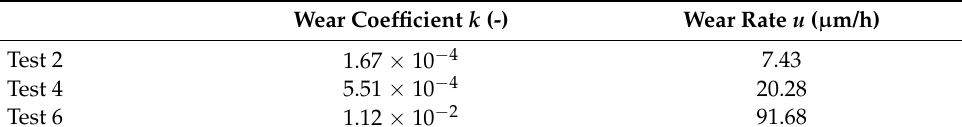
Table 11. Wear coefficient k and wear rate u of Si 3 N 4 ball for R t = 7 mm.